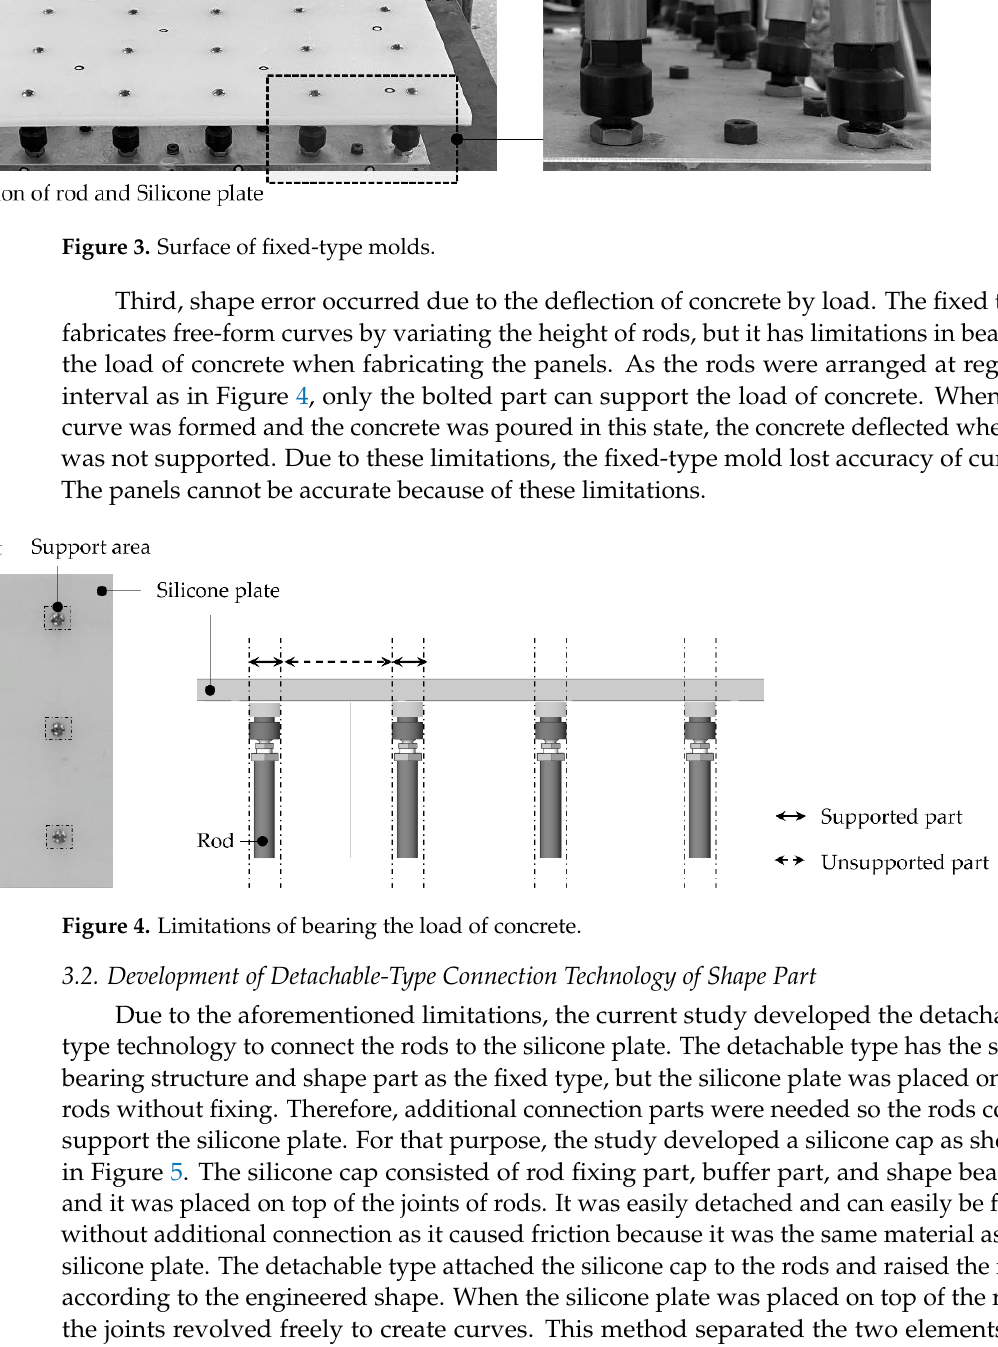
Figure 4. Limitations of bearing the load of concrete.